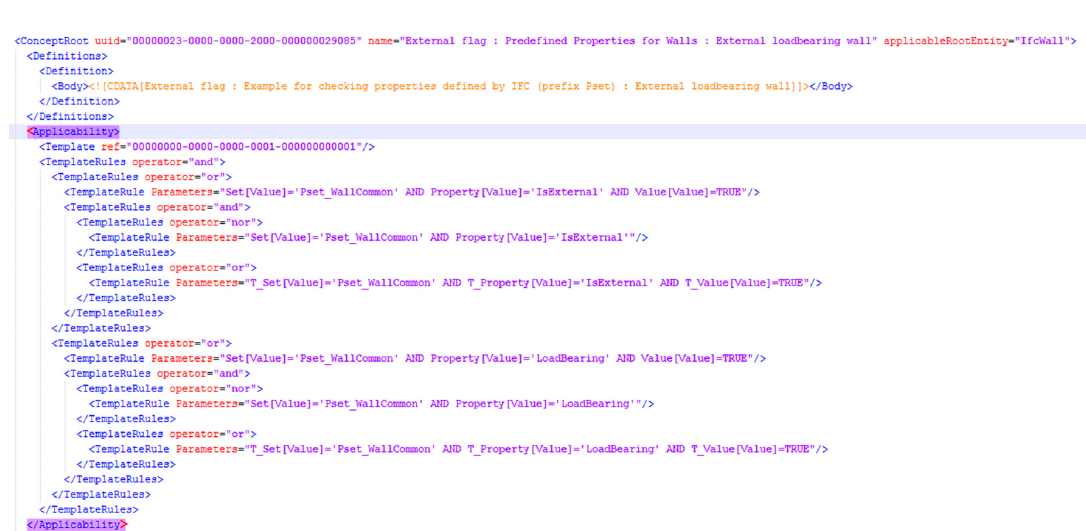
Figure 7. <Applicability> definition of a requirement.